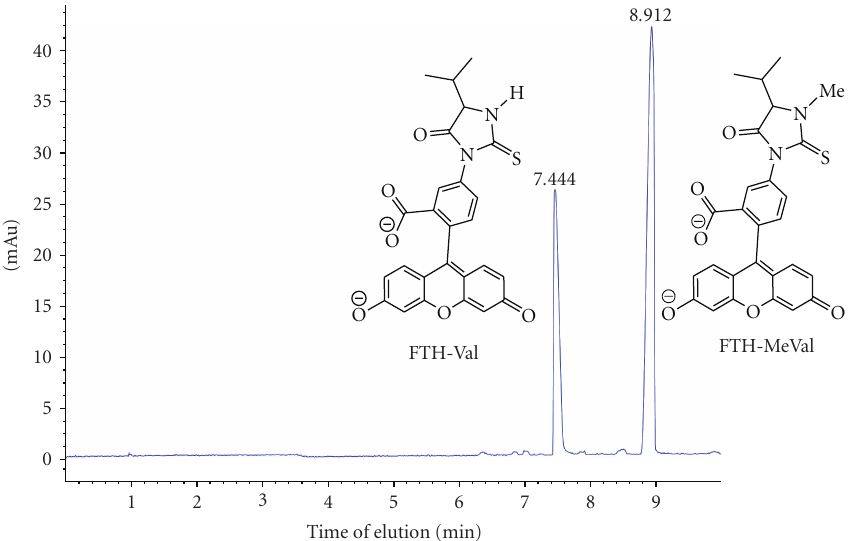
Figure 5: Separation of FTH-Val and FTH-MeVal by capillary electrophoresis and detection with a diode